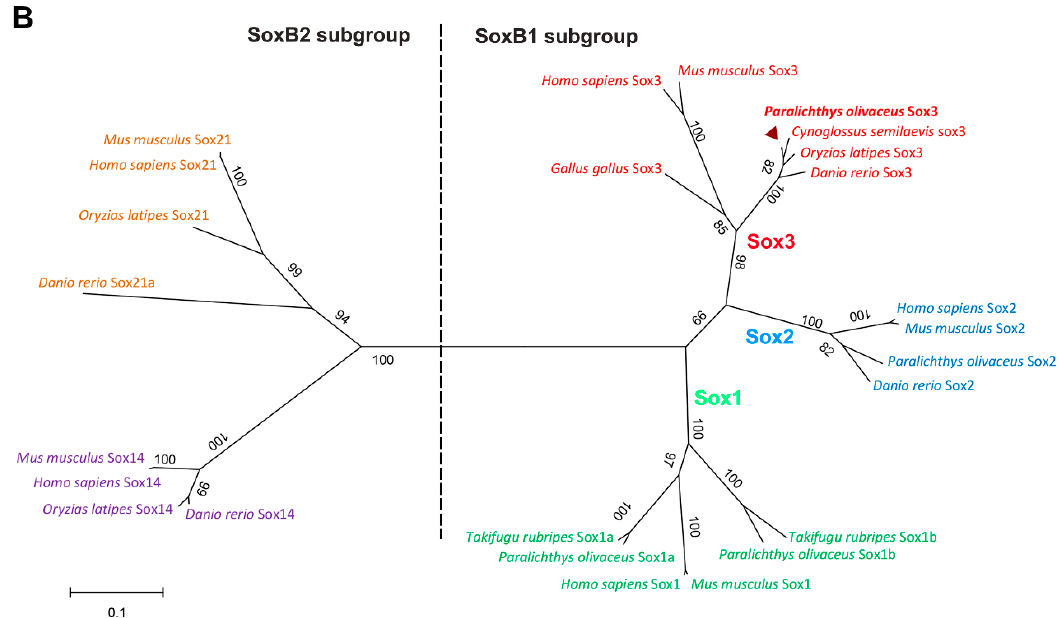
Figure 2. PoSox3 amino acids alignment and phylogeny. ( A ) Alignment of HMG-box domain of PoSox3 with those of other vertebrate orthologues. Different amino acid residues between fish and tetrapods are indicated with asterisks; ( B ) Phylogenetic relationships of PoSox3 and SoxB proteins from other representative species. The Neighbor-Joining tree was constructed by MEGA (version 6.06) with 1000 bootstrapping based on the full-length amino acids sequences. The sequences were obtained with the following GenBank accession numbers: Homo sapiens : NP_005977.2 for Sox1;